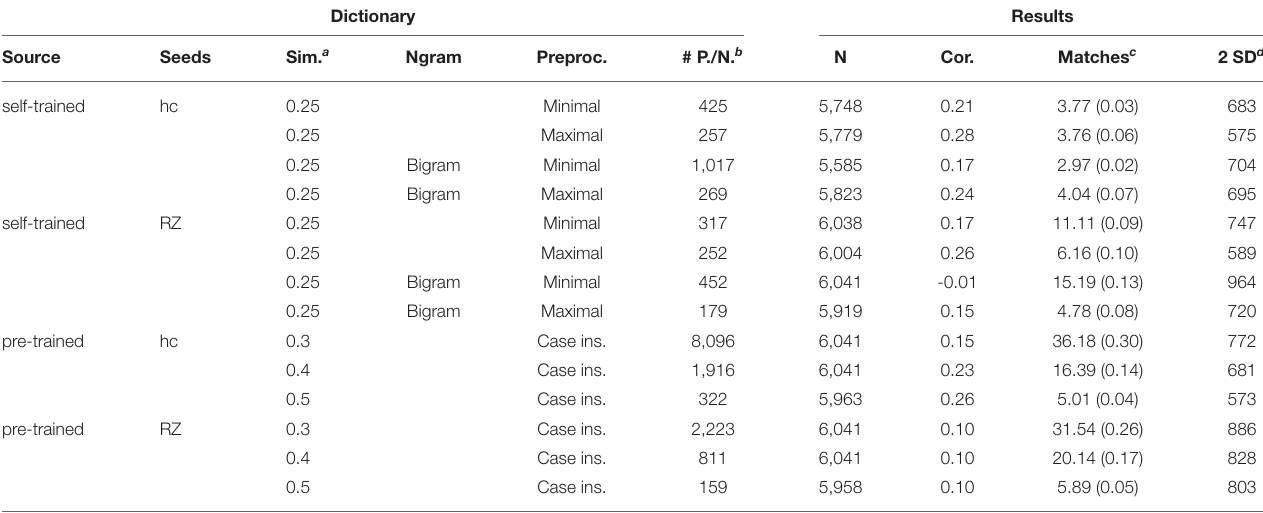
TABLE 4 | Characteristics and results for self- and pre-trained GloVe dictionaries. Dictionary Results